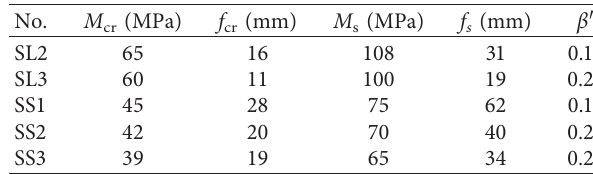
Table 4: Calculation results of elastic-plastic stiffness coefficient.